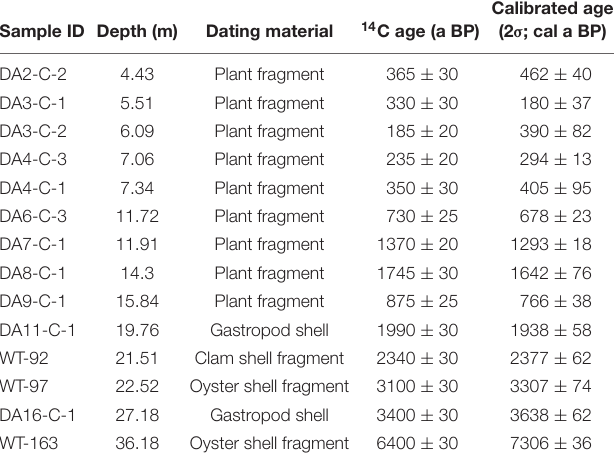
TABLE 2 | Radiocarbon dates from core